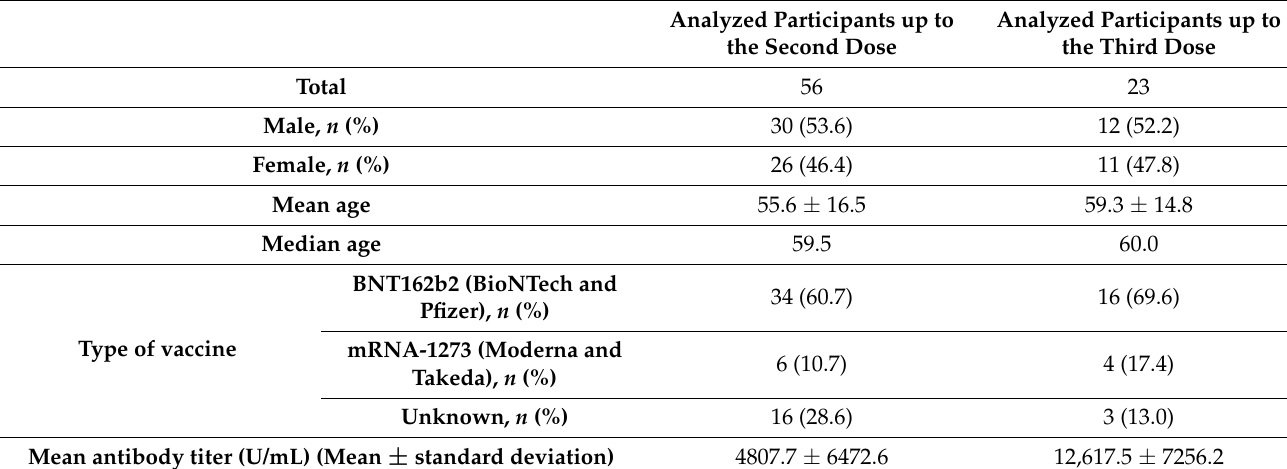
Figure 2. SARS-CoV-2 antibody titers in participants with no history of COVID-19 infection who had antibodies measured after the second dose of the vaccine. Table 2. Analyzed participants up to the second and third vaccine